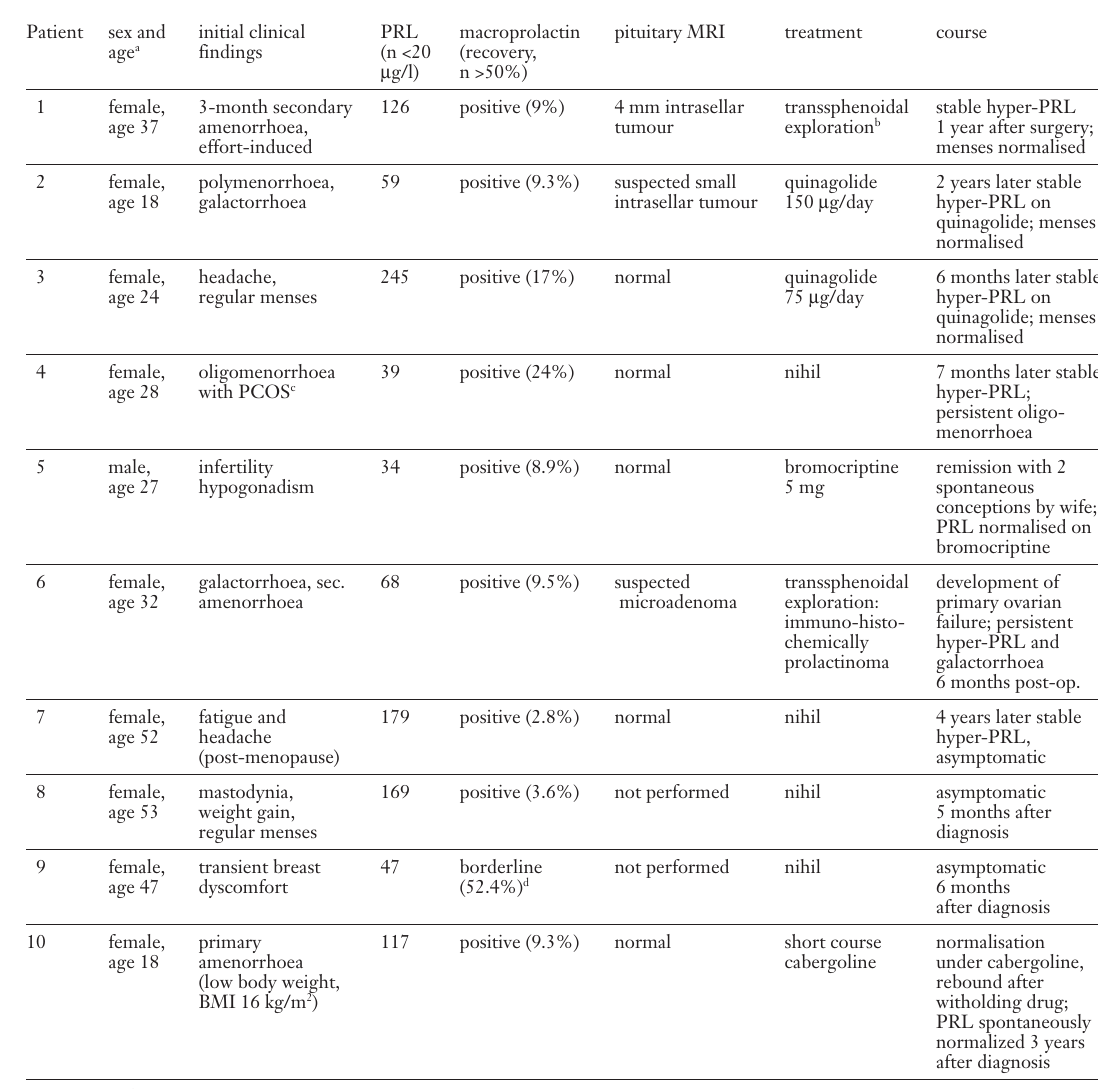
Clinical data of 10 pa- tients with macro- prolactinaemia.